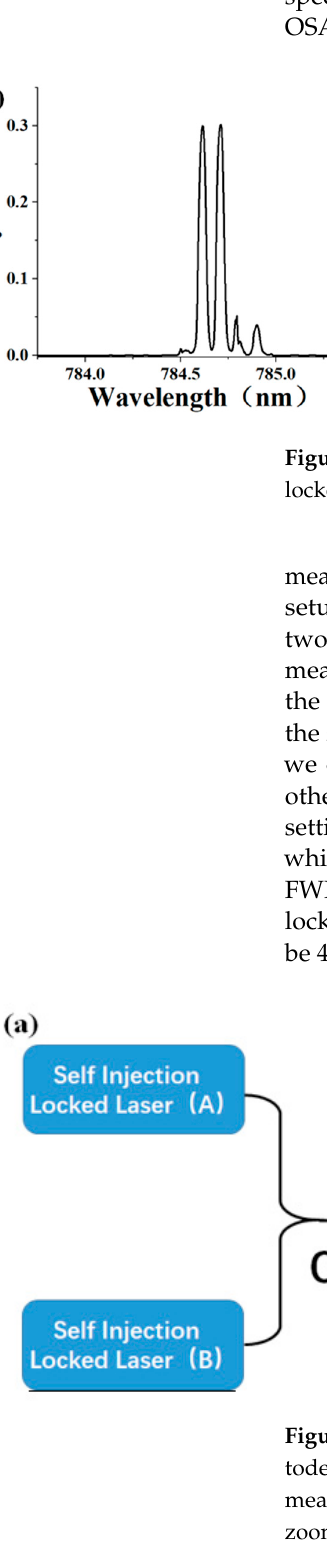
4 of 6 Figure 2. Setup of the self-injection-locked laser using the HFFPF. LD: laser diode; L: aspherical lens; HFFPF: High fi nesses Fabry–Pérot fi lter; M: 90 %-transmissivity partial-re fl ection mirror; SMF: single mode fi ber. Then we characterize the output spectrum of the self-injection-locked laser. For comparison, we fi rst measure the free-running spectrum of the LD using an optical